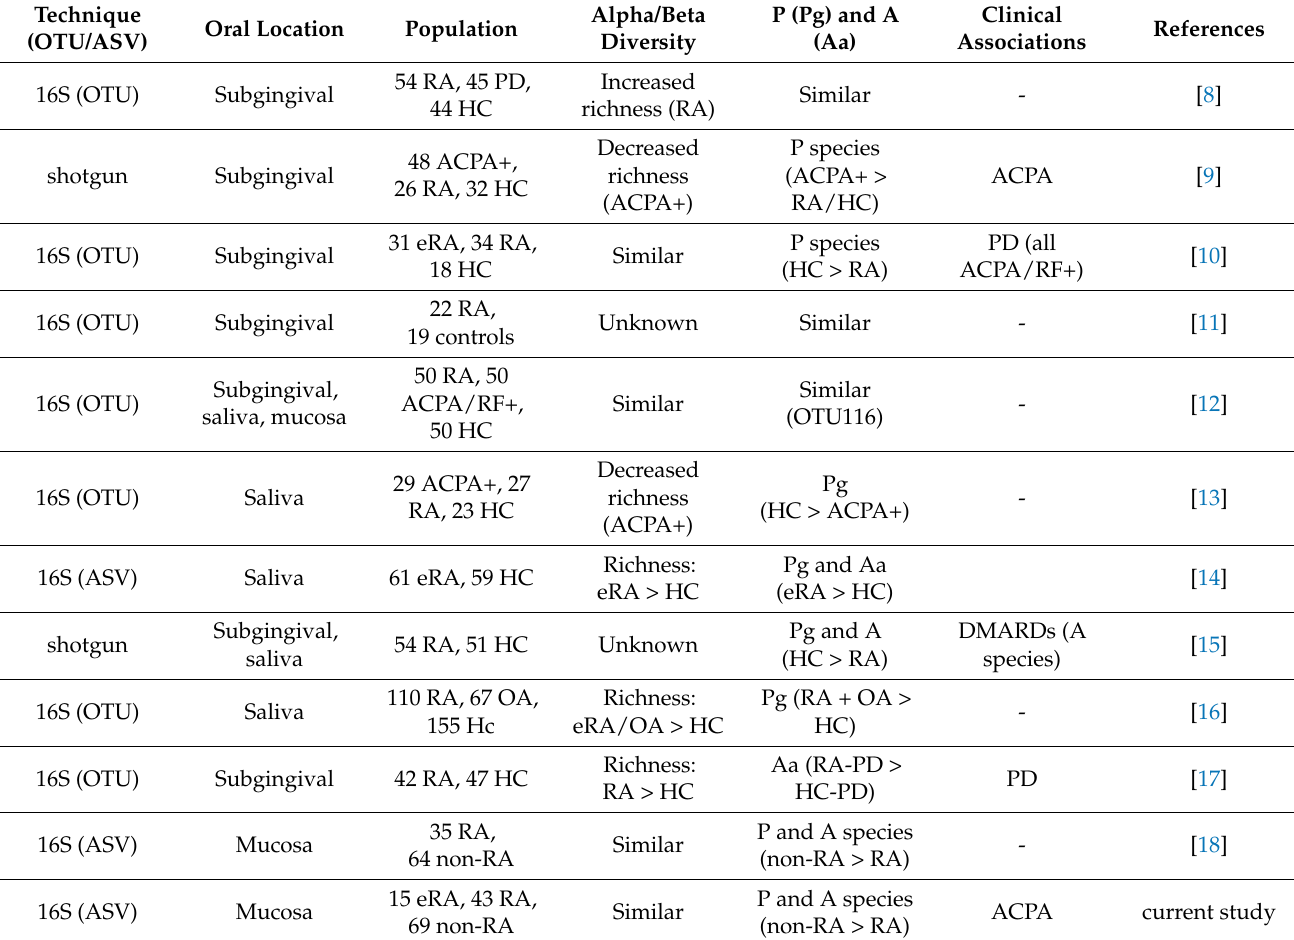
Table 1. Impact on the oral microbiome of rheumatoid arthritis (RA) and of individuals with anti- citrullinated protein/peptide antibodies